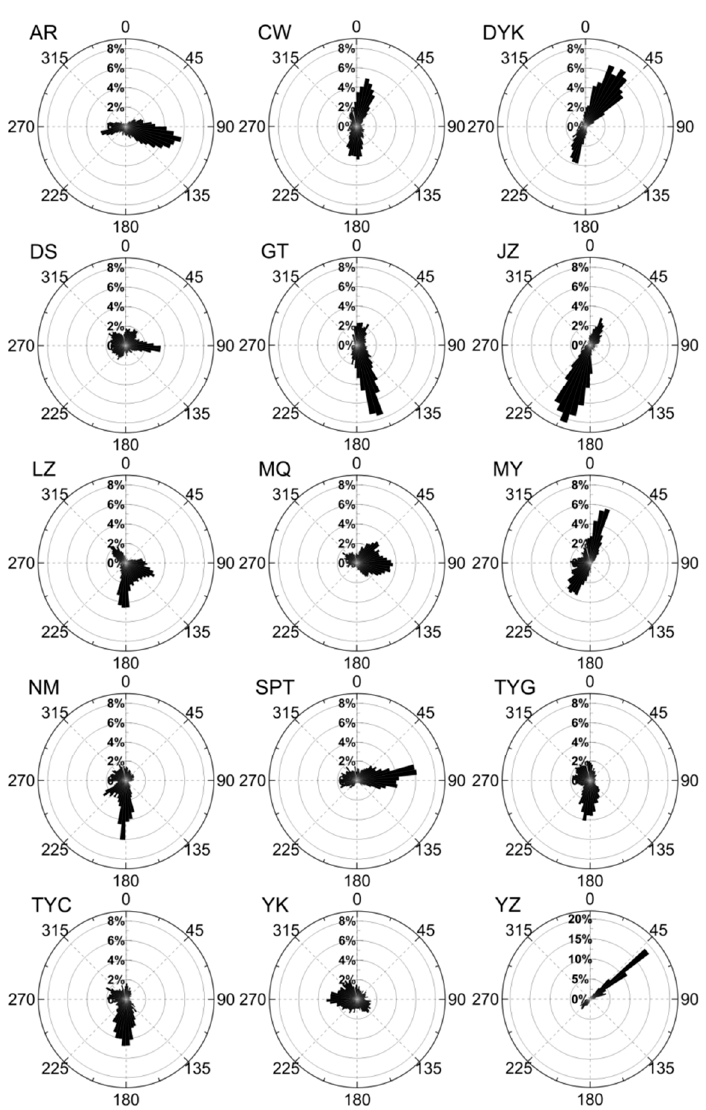
Figure 3. Rose charts of wind direction frequency of the 15 flux sites in this study. For each site, spatial distribution of prevailing wind direction presented similar spatial pattern as footprint climatology (Figure 2).